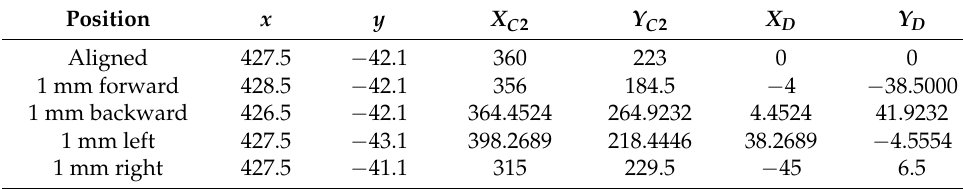
Table 4. Measurement data for No. 6 screw hole.